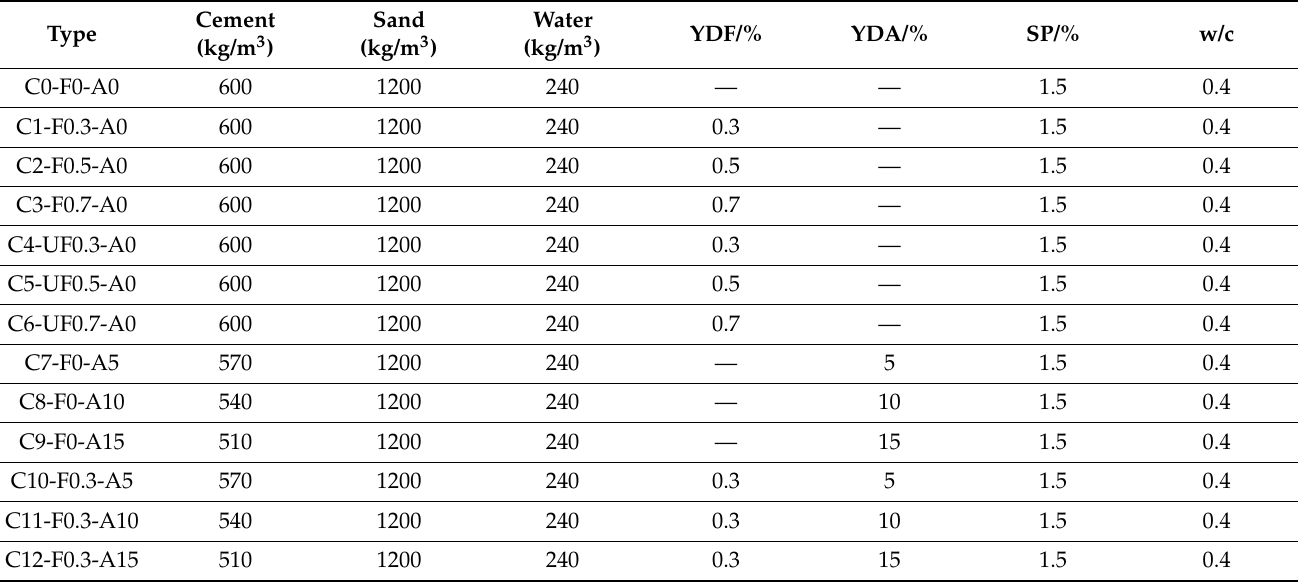
Table 4. Mix proportions of YDF and YDA reinforced cementitious mortar specimen a